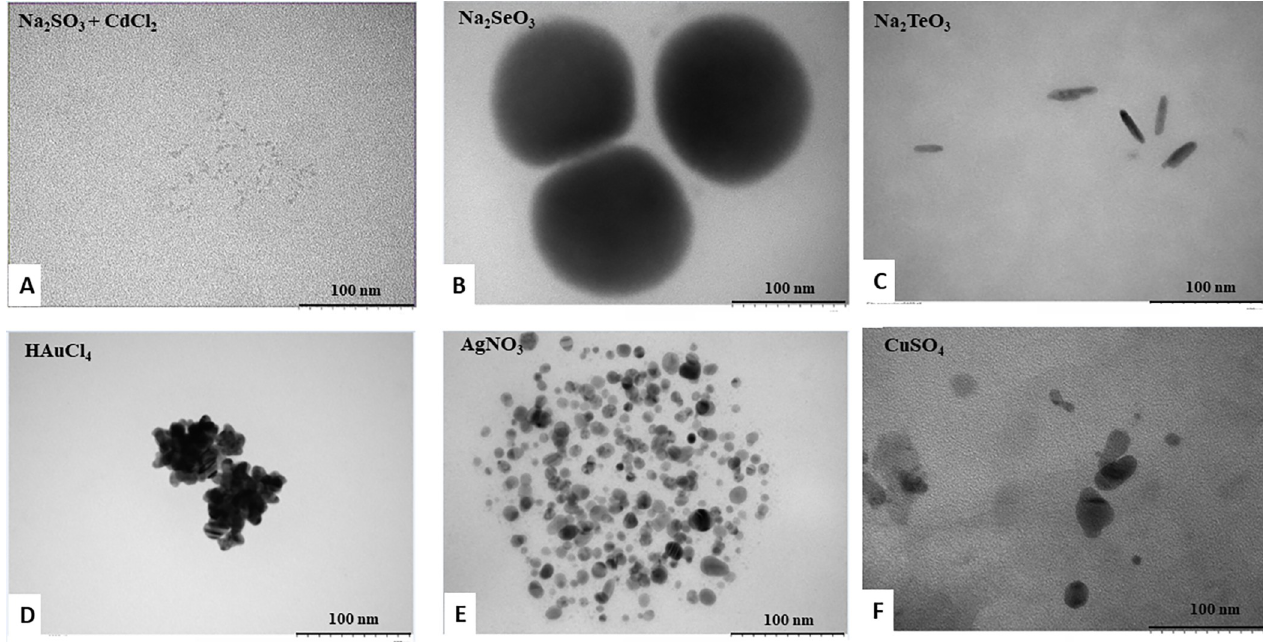
Fig 6. TEM of NS from in vitro synthesis by crude extracts of MF05. NS obtained after treatment with (A) Na 2 SO 3 + CdCl 2 ; (B) Na 2 SeO 3 ; (C) Na 2 TeO 3 ; (D) HAuCl 4 ; (E) AgNO 3 or (F) CuSO 4